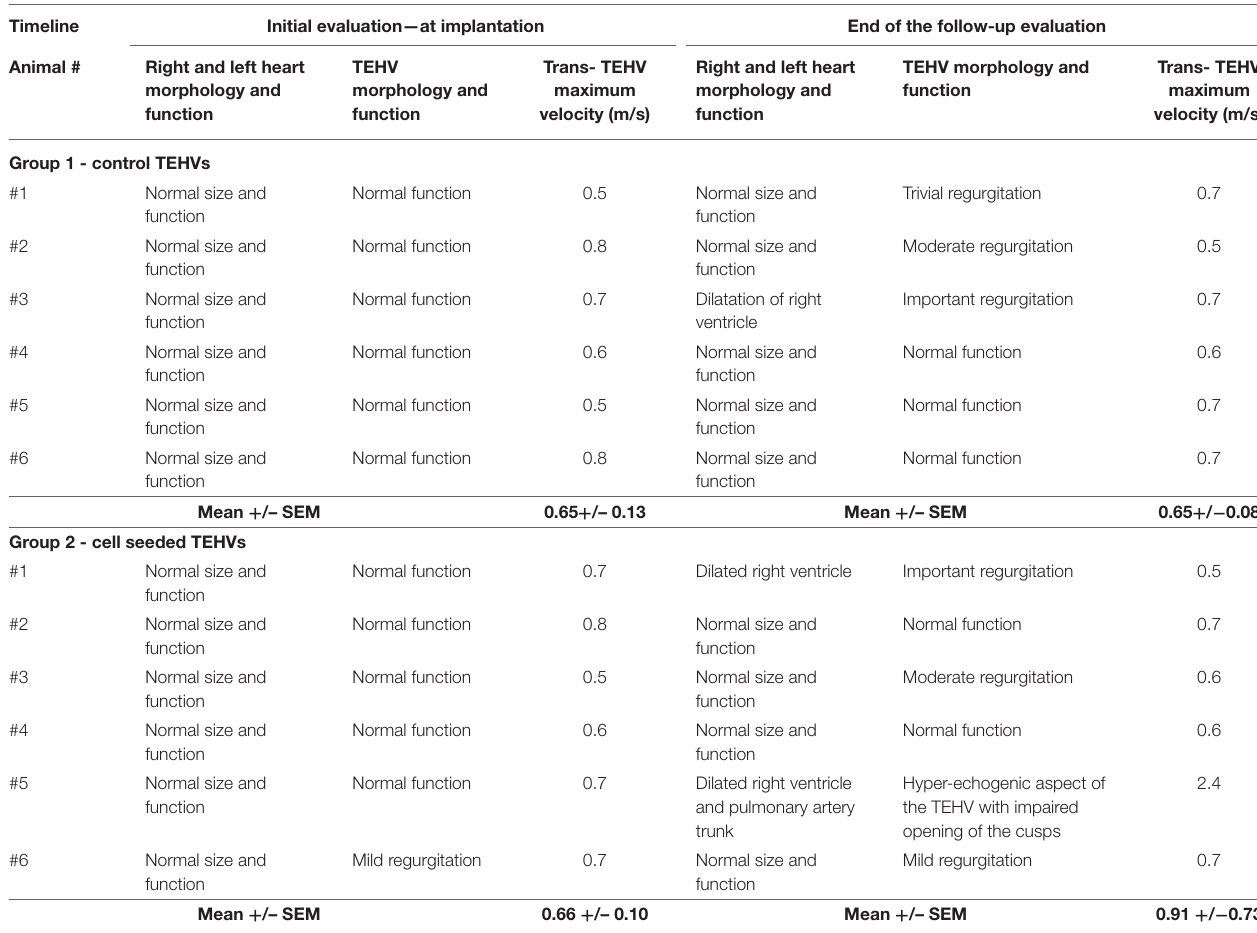
TABLE 1 | Echocardiographic evaluation of the